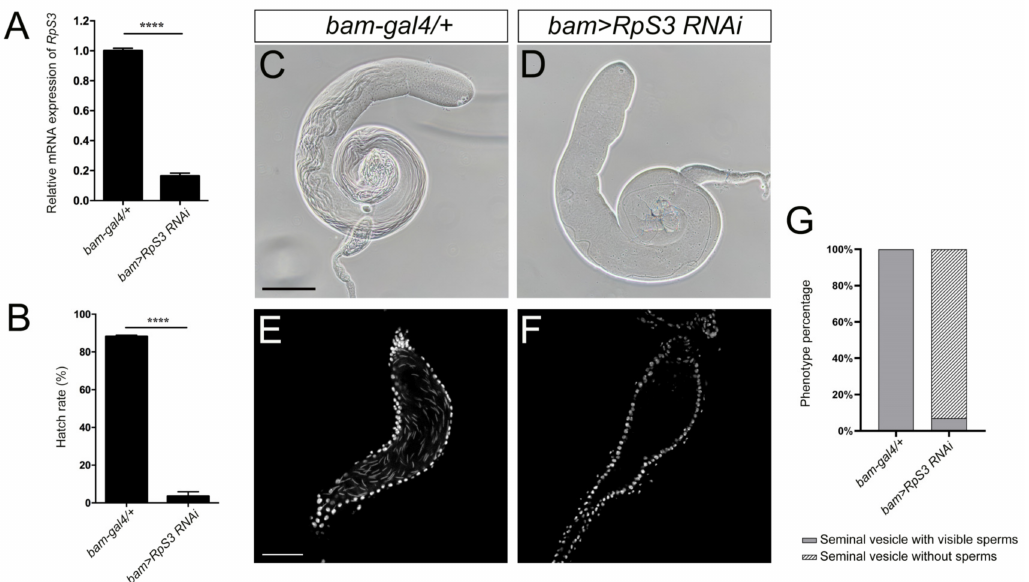
Figure 2. Knockdown of RpS3 in testes dramatically decreased fly male fertility. ( A ) The RpS3 expression level was significantly reduced in bam>RpS3 RNAi testes. ( B ) The hatch rate of eggs from the cross of wild-type females and bam>RpS3 RNAi males was significantly lower than that of eggs from the control group. **** p < 0.0001. ( C , D ) The bright-field photograph of control ( C ) and RpS3 knockdown ( D ) testes. ( E , F ) The mature sperms in the seminal vesicles of the control testis ( E ) or RpS3 -knockdown testis were visualized by DAPI staining. ( G ) The percentage of the seminal vesicle with or without mature sperms was quantified in the control group ( n = 37) and in the RpS3 -knockdown group ( n = 45). The Chi-square test showed a significant relationship between sperm production and RpS3 knockdown, X 2 (1, N = 82) = 70.79, p < 0.0001. Scale bars: 200 µ m ( C , D ); 50 µ m ( E , F